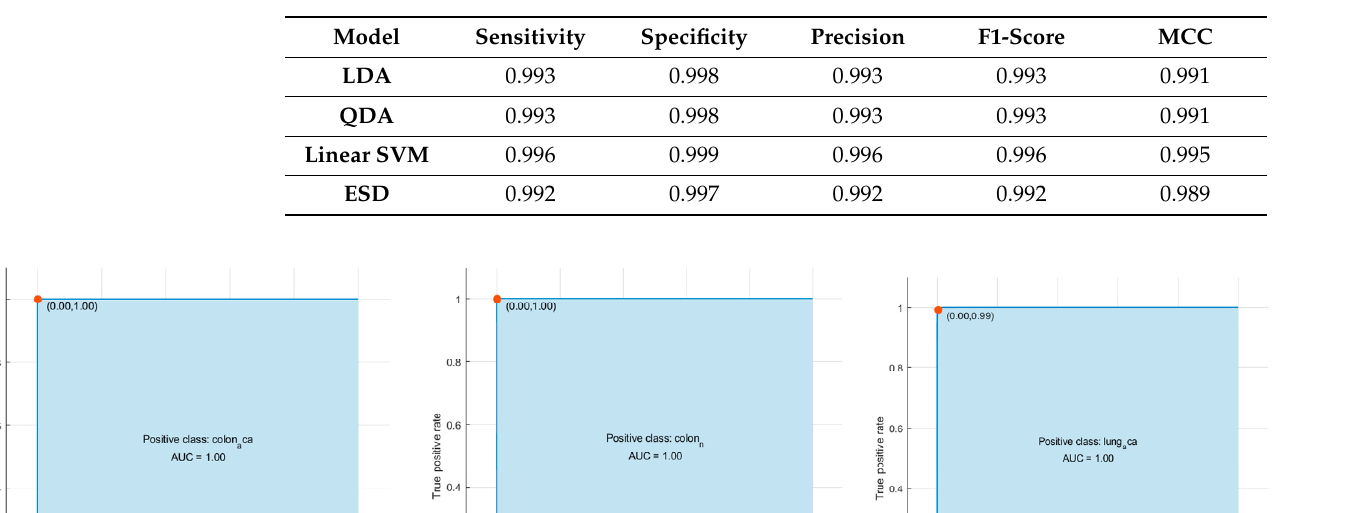
Table 4. Performance measures attained using the combined FHWT coefficients of the three CNNs via the DWT method.